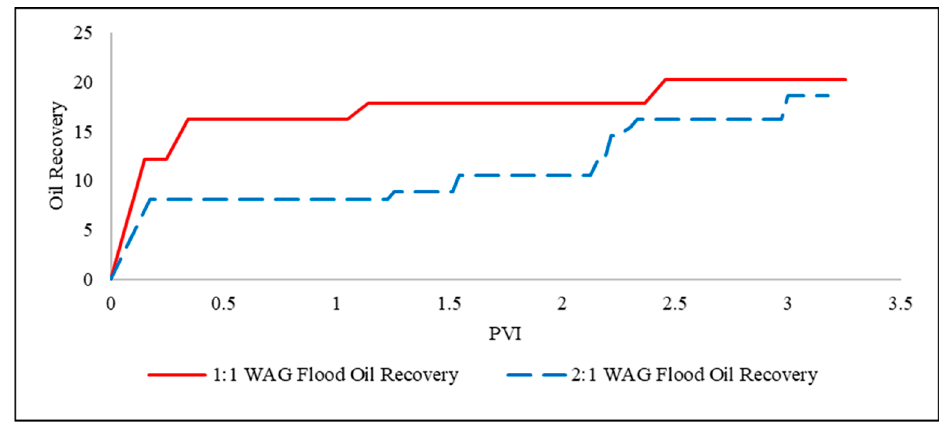
Figure 13. Oil recovery curves for Copper Ridge dolomite miscible WAG floods.